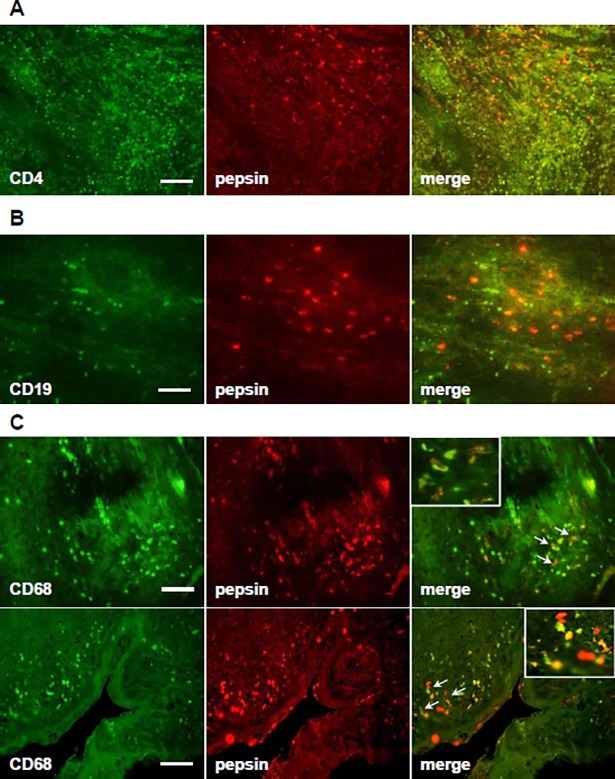
Co-localization of pepsin and lymphocytes in hypertrophic tonsil sections.No co-localization of pepsin with CD4- (A) and CD19 (B)-positive cells was detected. Co-localization of pepsin and CD68-positive cells was detected in the surrounding germinal centers (C, upper) and crypt epithelium (C, lower). Scale bar equals 50 μm.